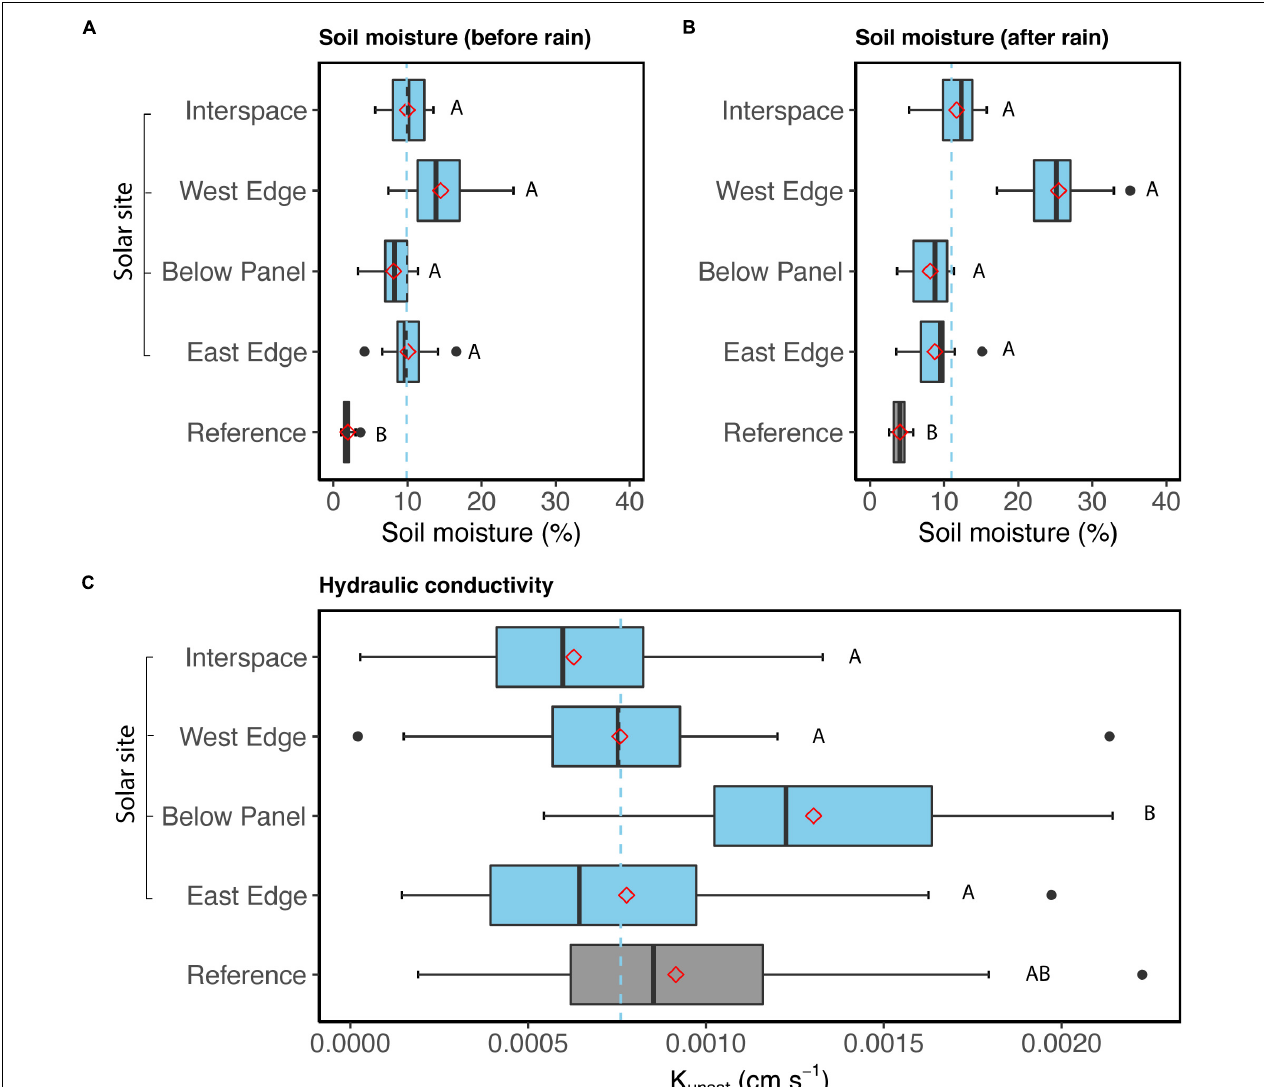
FIGURE 1 | Soil moisture (A) before and (B) after a precipitation event in the reference grassland and in locations beneath solar modules. (C) Unsaturated hydraulic conductivity (K unsat ) in the reference soil and in locations beneath solar modules. Box plots show medians (solid lines) and interquartile ranges (box enclosures), with whiskers extending to the most extreme observation ≤ 1.5 × the interquartile range beyond the box. Also shown are means (red diamonds) and individual observations beyond whiskers (black circles). Location categories share letters if pairwise comparisons did not identify significant differences between